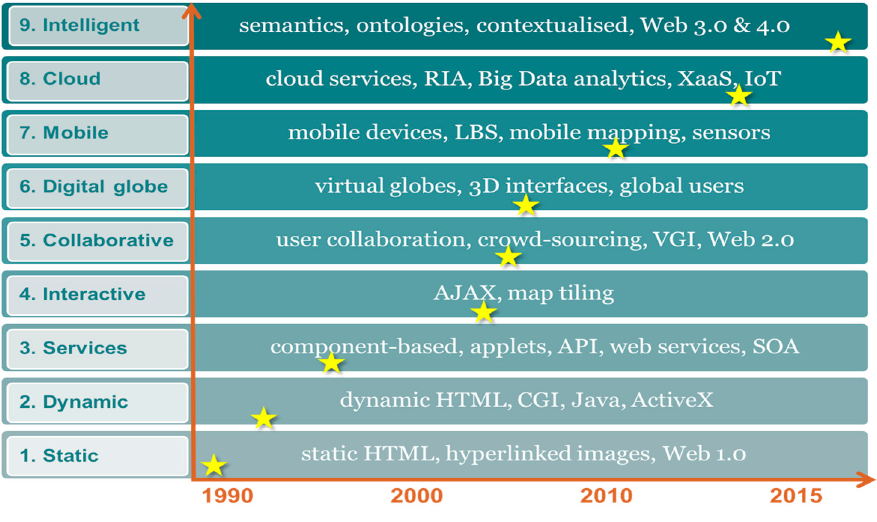
Figure 2. Framework of web mapping eras (Adapted from [18]).